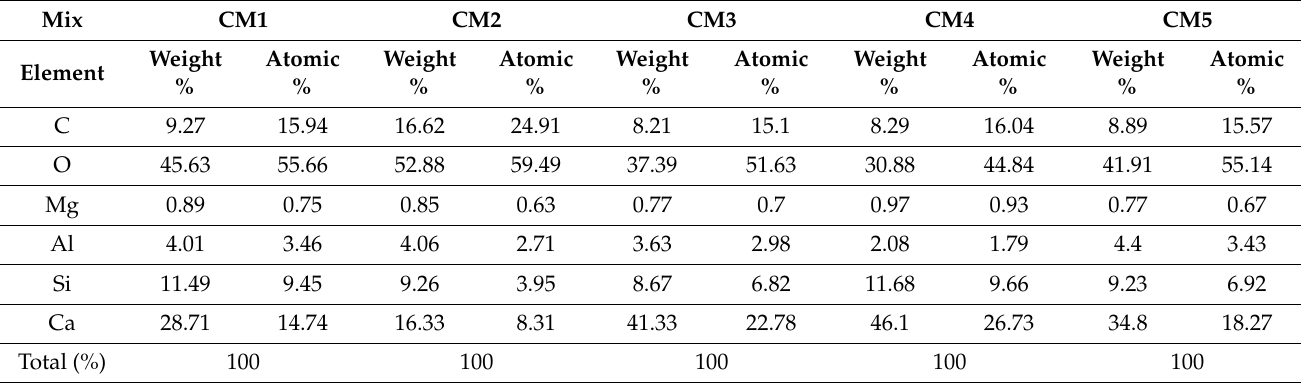
Table 4. Element composition of